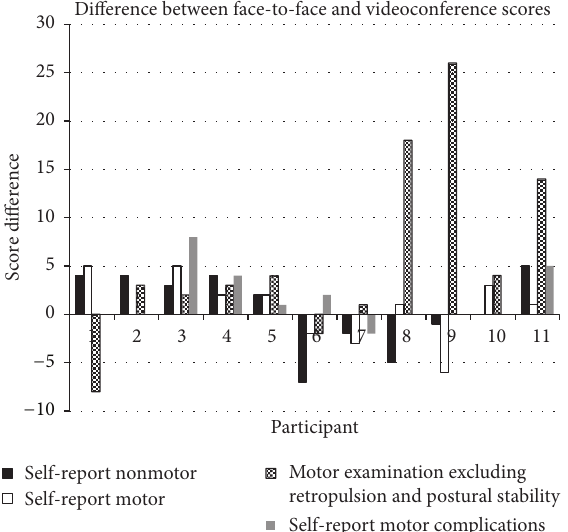
Figure 2: Difference between face-to-face and Internet-based videoconference assessment scores per participant for each MDS-UPDRS